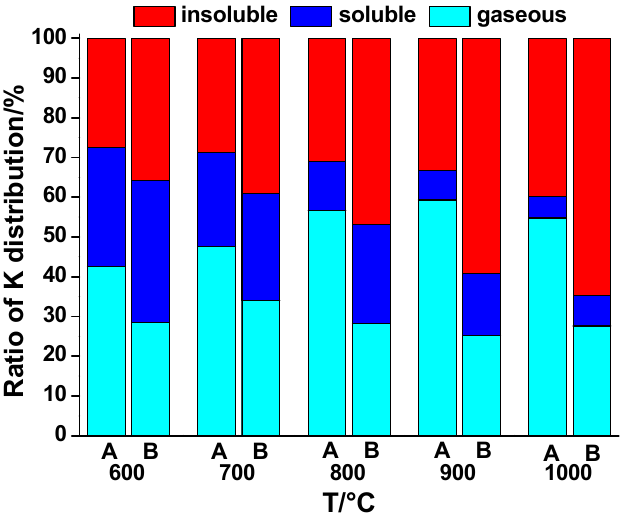
Figure 4. Distribution of K in the case of: ( A ) WS combustion; ( B ) co-combustion.